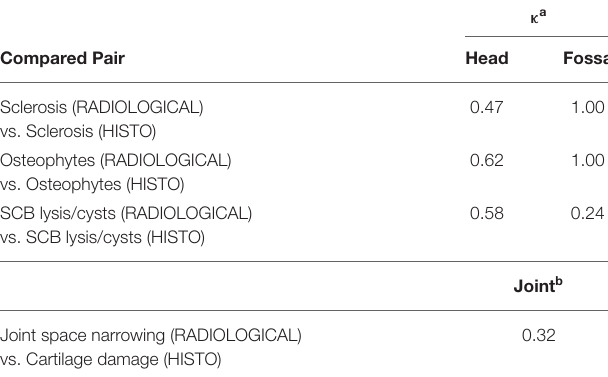
TABLE 4 | Summary of kappa statistics for agreement of binary assessment (yes/no).